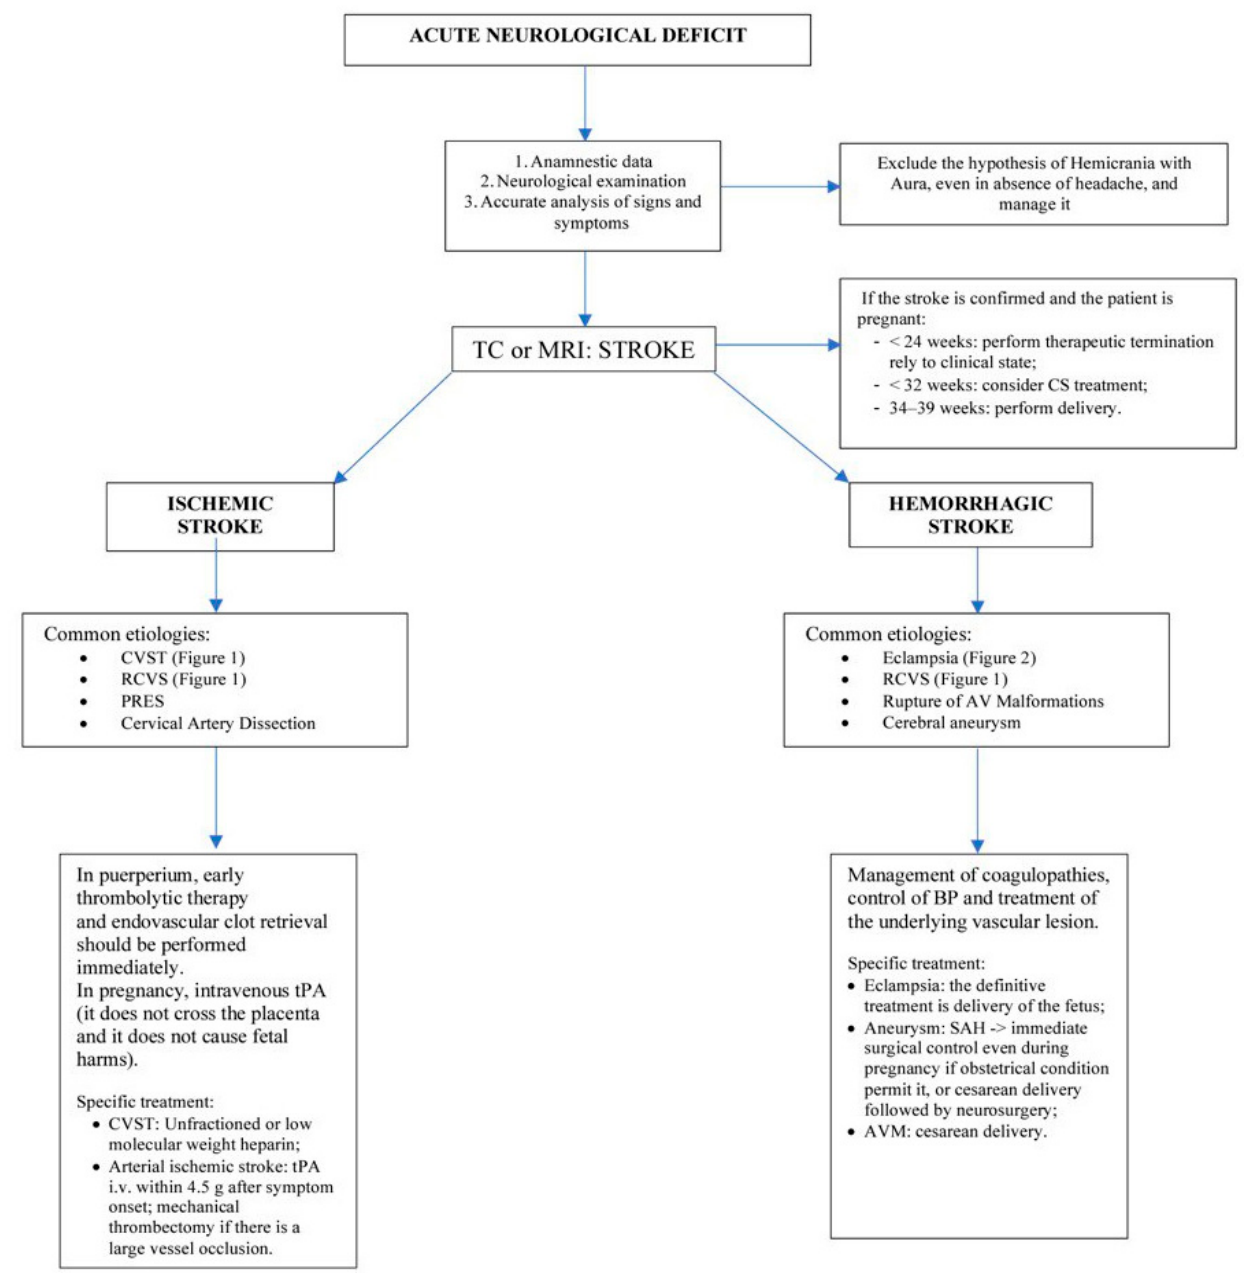
Figure 3. Algorithm for managing acute neurological deficit in the clinical se tt ing.